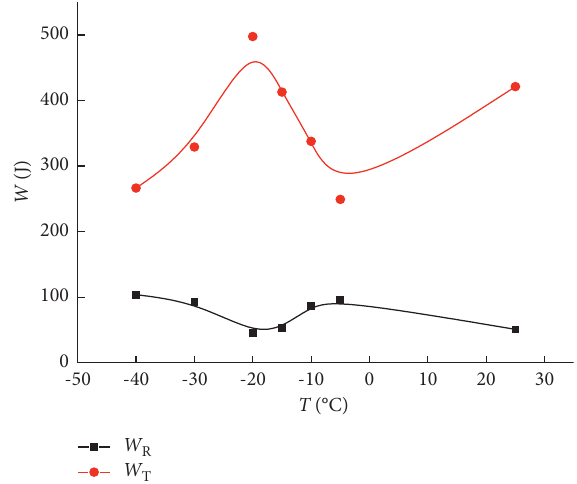
Figure 15: Reflected and transmitted energy vs. temperature.